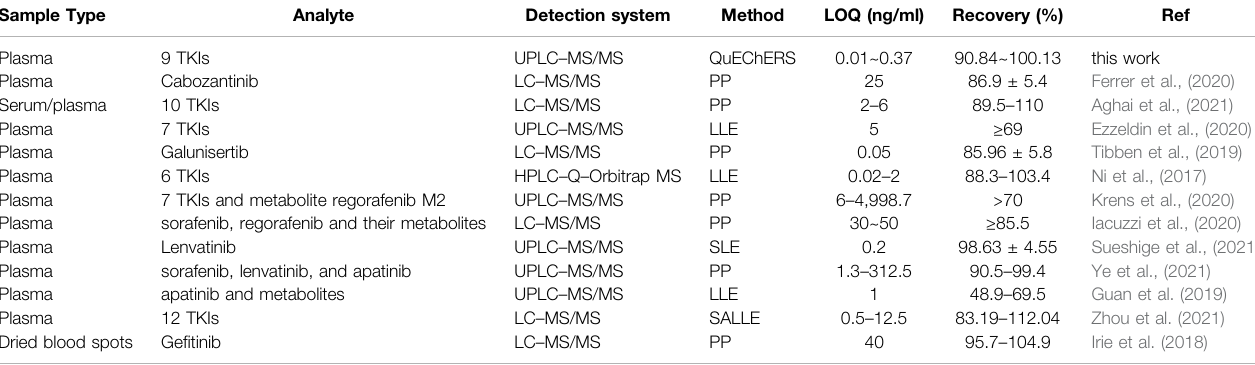
TABLE 6 | Comparison of the proposed method with other published methods for the quantitative detection of TKIs with anti-hepatocellular carcinogenic effects. Sample